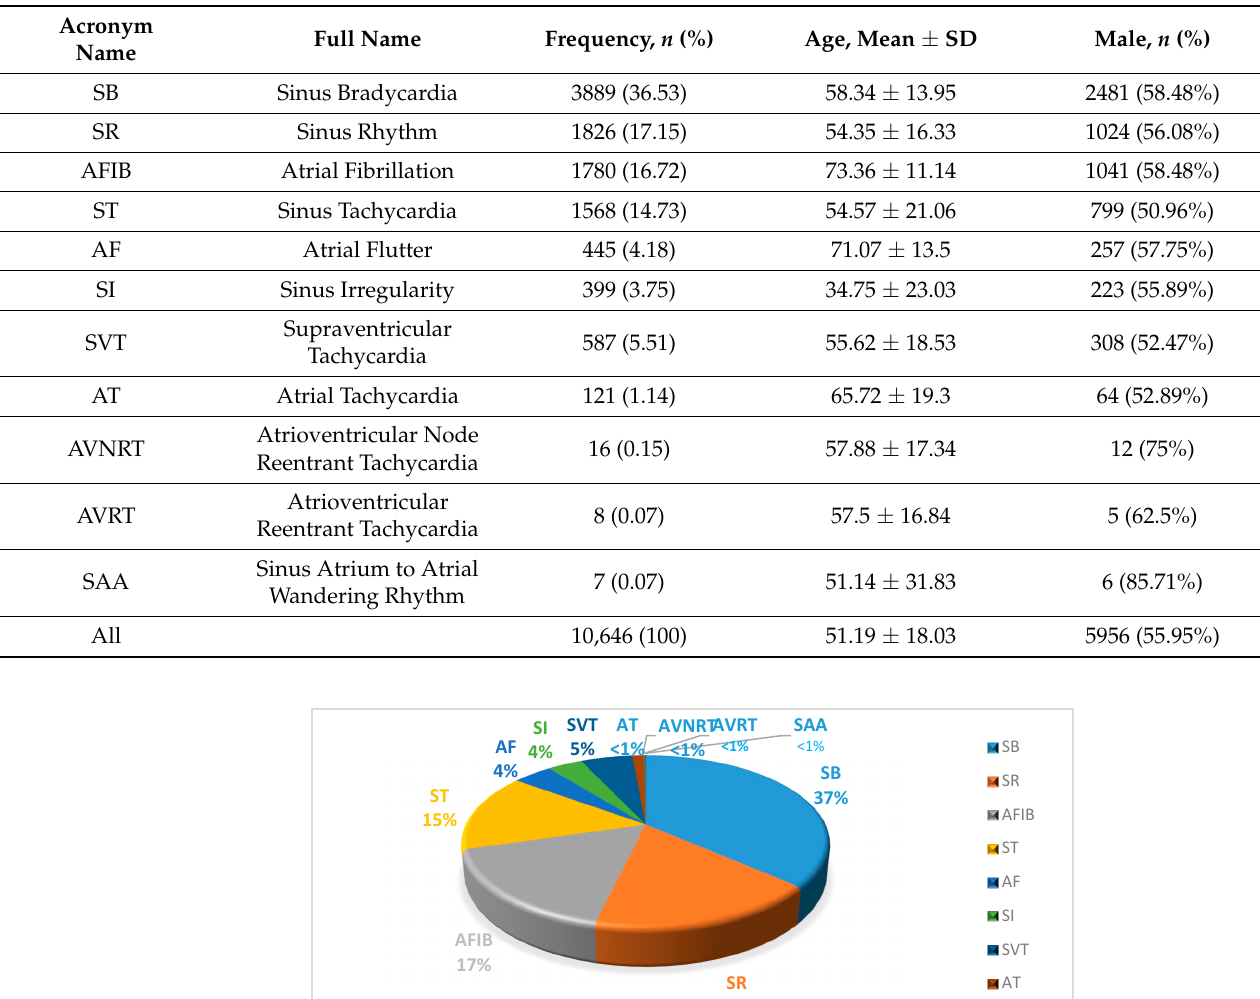
Table 1. Rhythm information and basic characteristics of the participants.